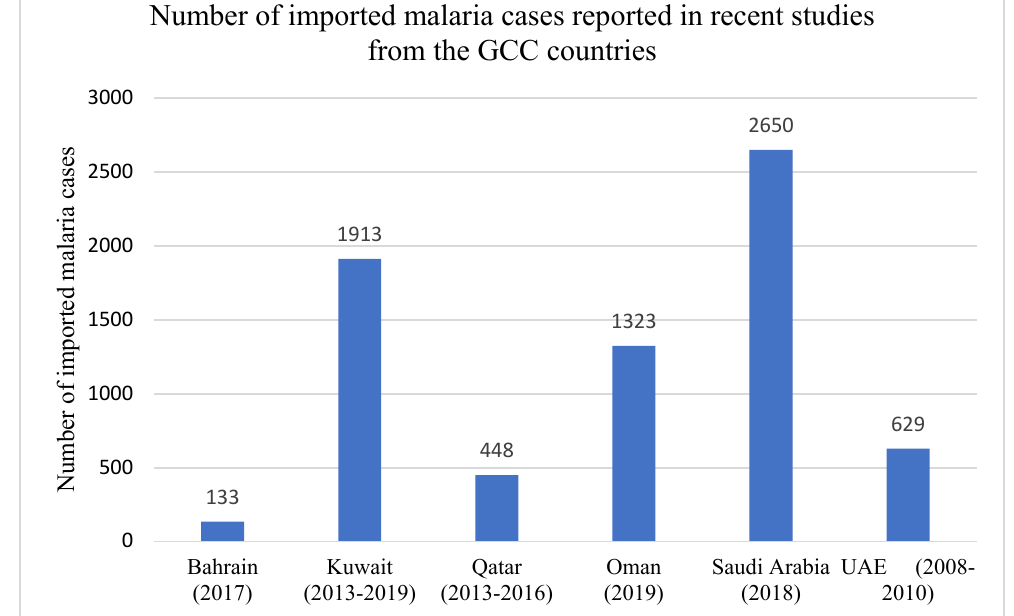
Figure 2. Number of imported malaria cases in GCC countries. The graphs were made using data adopted from WHO, World Malaria Reports, 2019 and 2020 and the Malaria Atlas Project 2019.